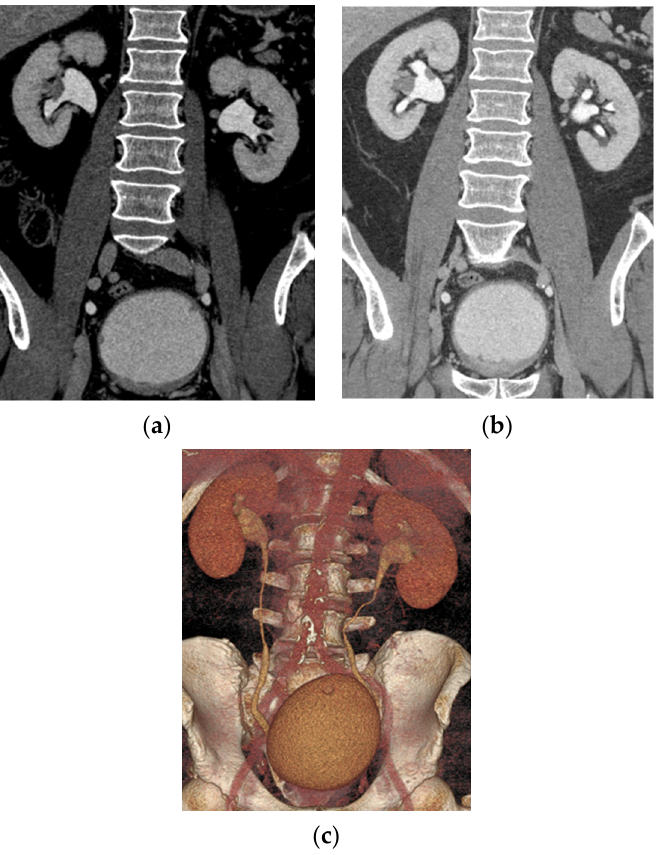
Figure 2. CT urogram showing synchronous upper and lower tract urothelial carcinoma. ( a ) Coronal CT image in the excretory phase shows multiple small bladder lesions (solid white arrow) and synchronous upper tract disease (dashed white arrow) ( b ) Coronal CT image slightly posteriorly, showing multiple upper tract lesions. ( c ) Coronal 3D volume rendering redemonstrates the findings with another bladder lesion (black